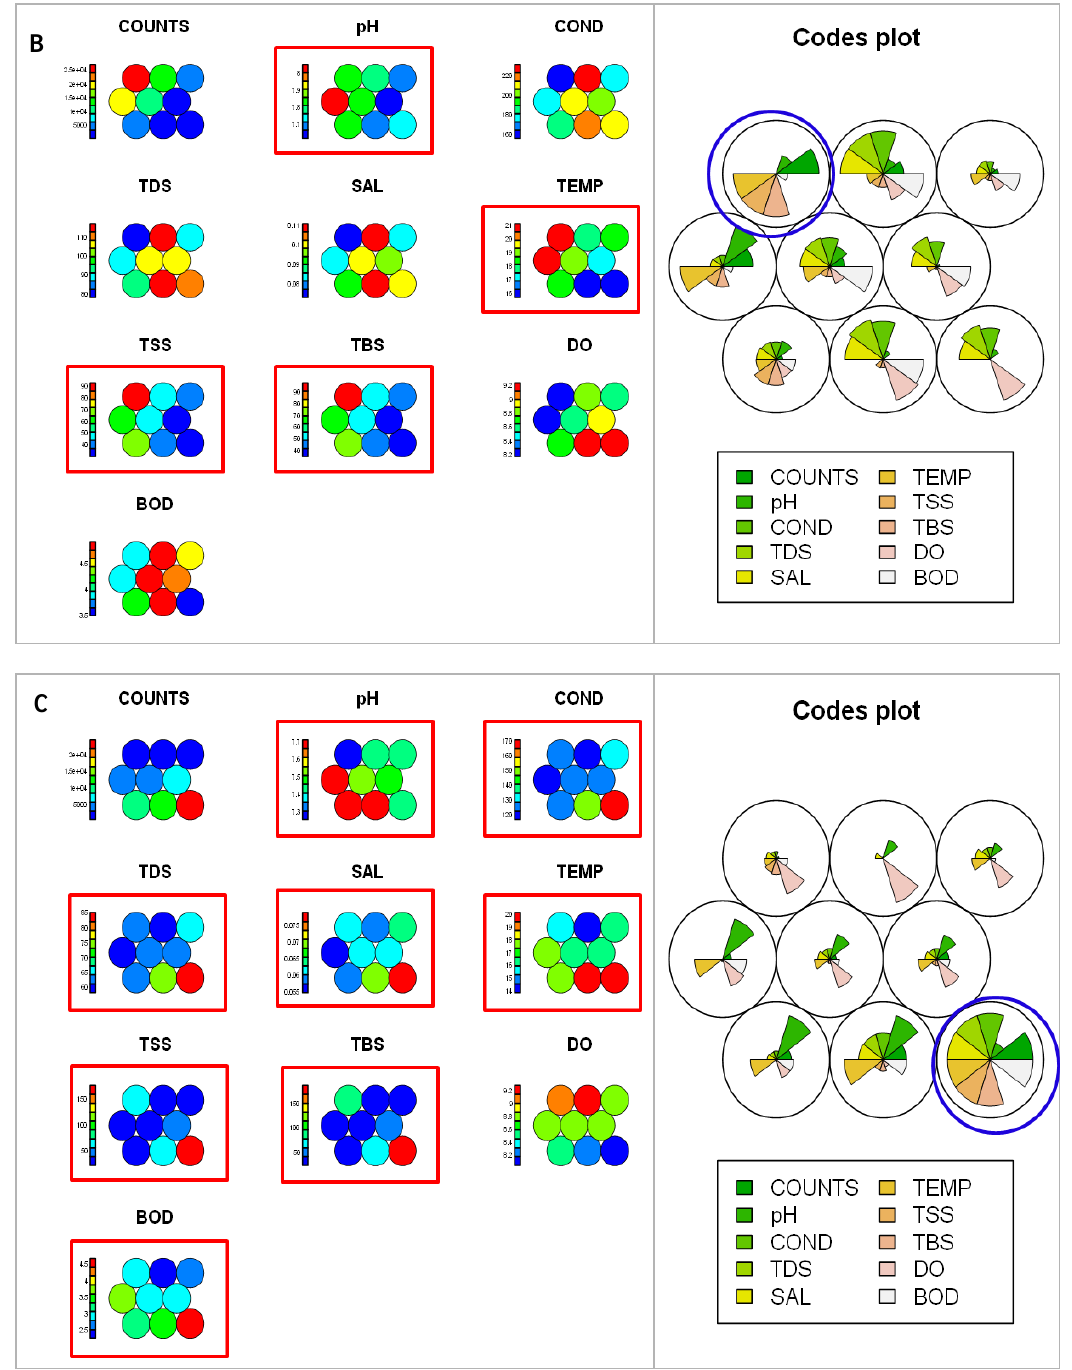
Figure 4. Kohonen topological graphs (self-organising maps - SOMs and Codes plot) showing a visual relationship between the physicochemical variables and Acinetobacter species density in: ( A ) Great Fish river: temperature, TSS, TBS and BOD were positively correlated with Acinetobacter species density; ( B ) Keiskamma river: temperature, TSS and TBS positively correlated with Acinetobacter species density; ( C ) Tyhume river: all physicochemical variables except DO and pH are correlated with Acinetobacter species density. The ruler shows the range of the variable, where RED is highest and blues the least values. SOMs and codes plots of the physicochemical variables that significantly contributed to the bacterial density in each of the rivers are captured in rectangle and circular shapes.